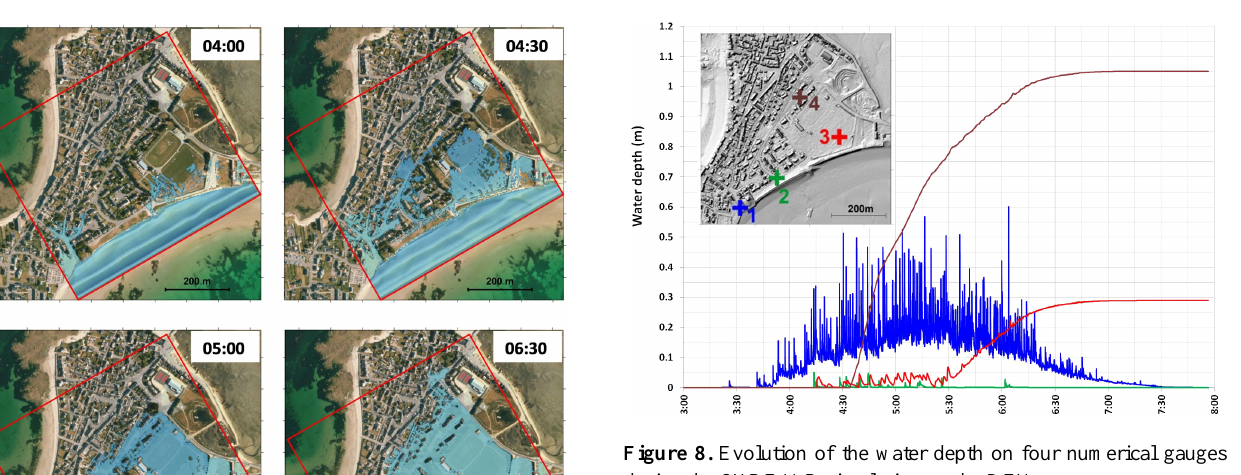
raphy strongly constrains the overtopping volume of water.